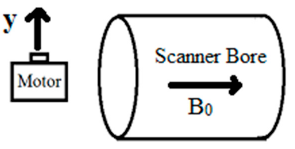
Figure 4. The motor orientation with respect to the bore.